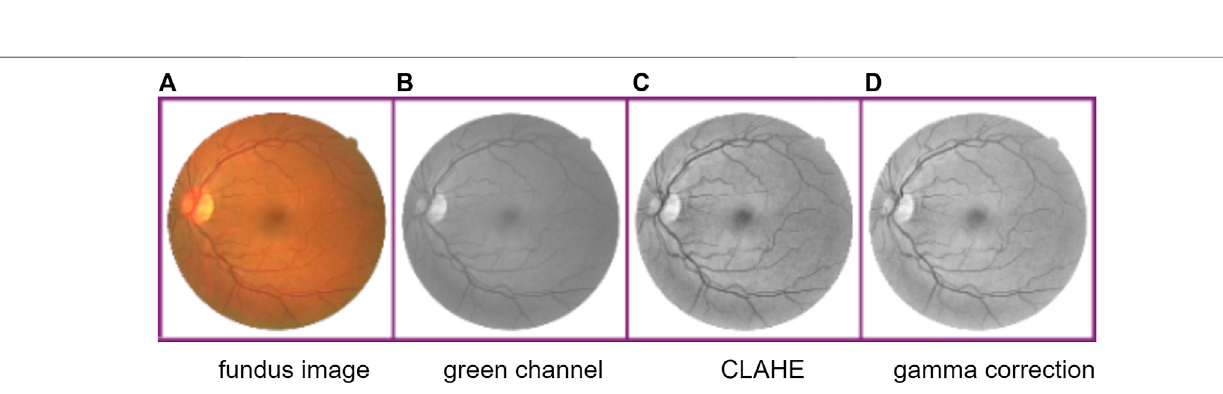
Frontiers in Bioengineering and Biotechnology |